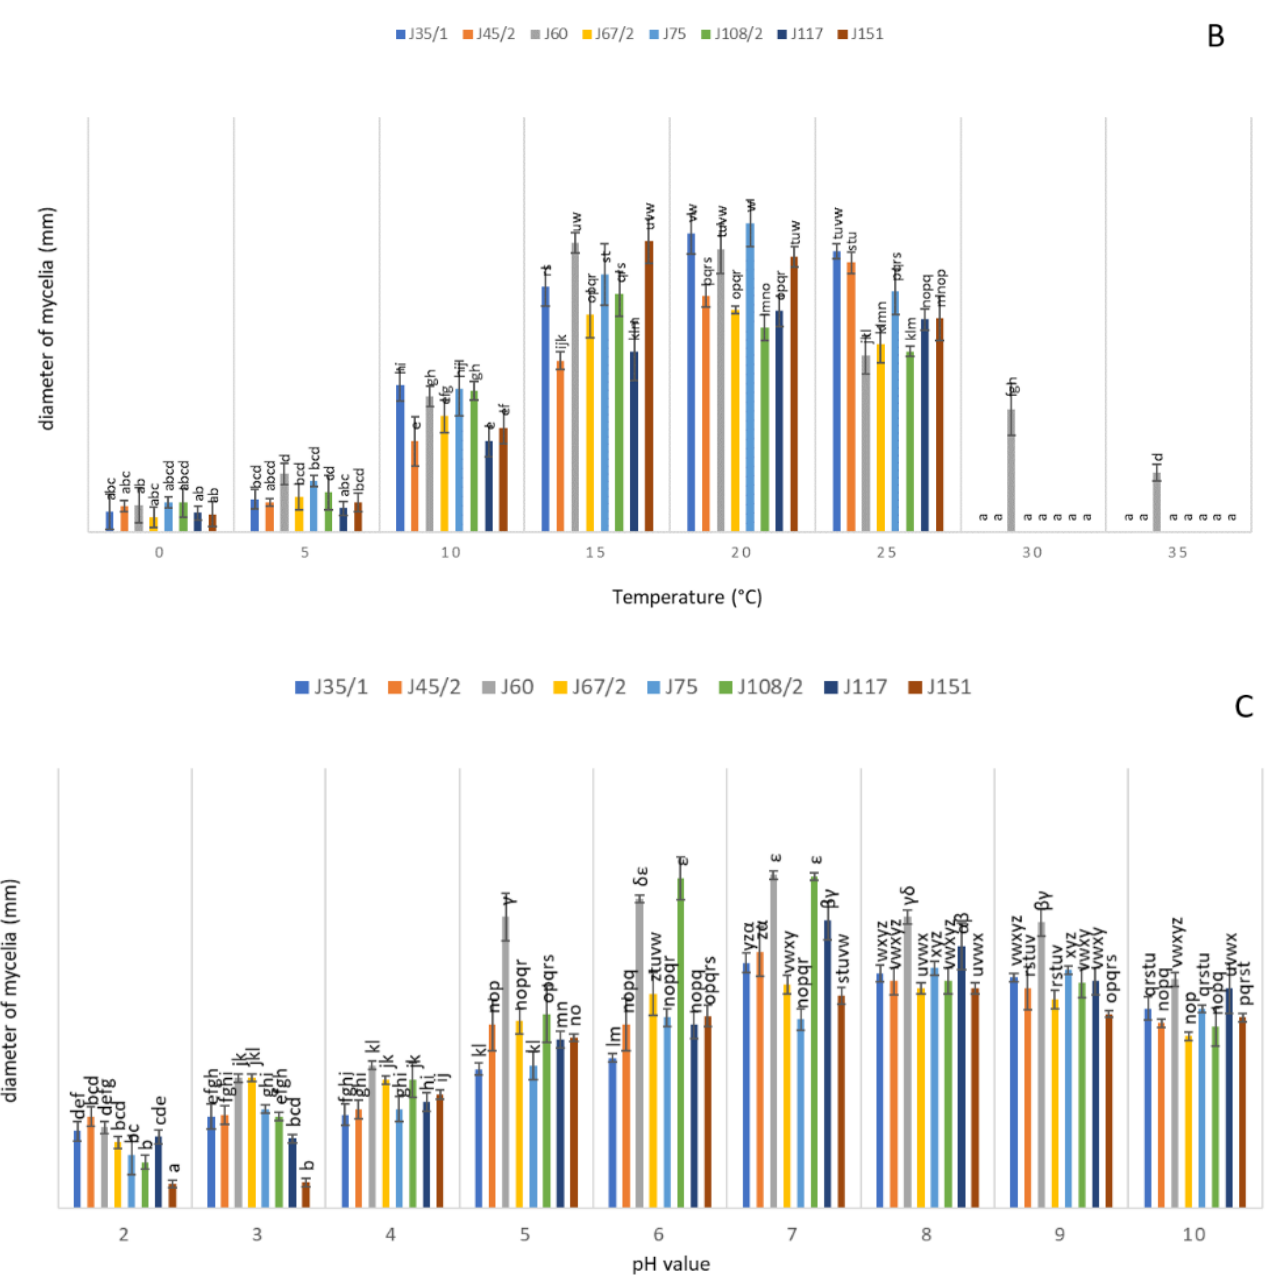
Figure 7. Effect of culture media ( A ), temperature ( B ), and pH ( C ) on growth of Neofabraea isolates. * Separation and group means were compared by Duncan’s test at p < 0.05; letters used for the definition of homogeneity belong to the English and Greek alphabet.